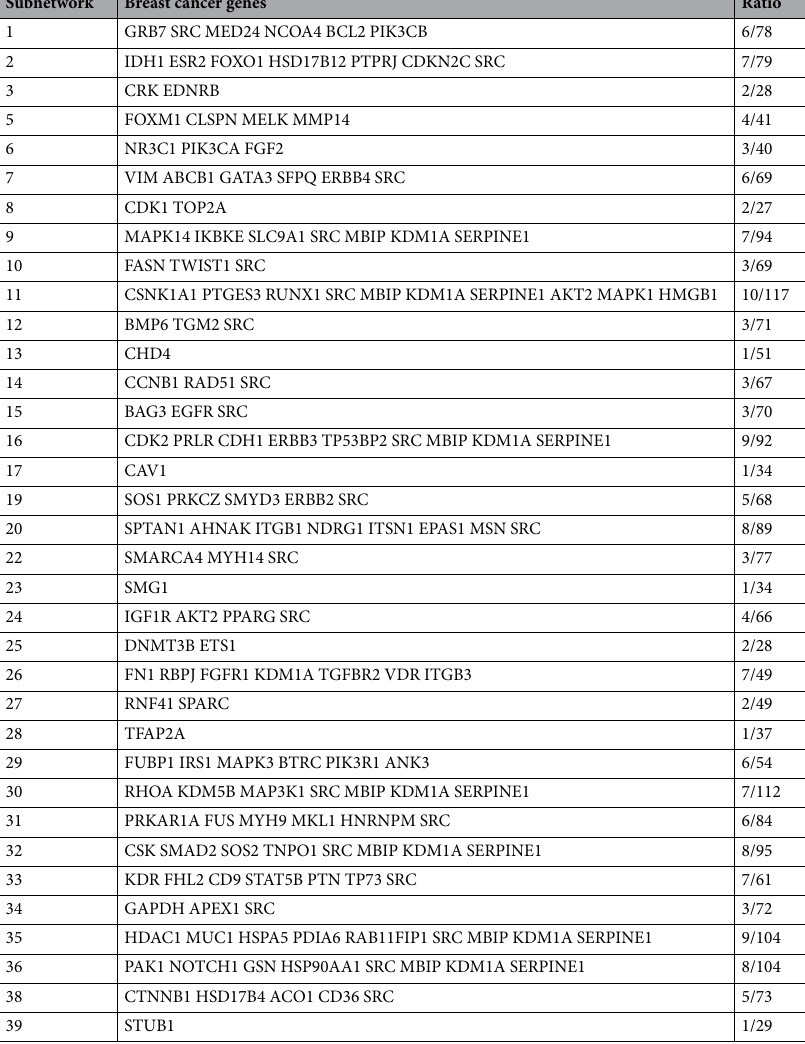
Table 2. Breast cancer genes in detected epigenetic